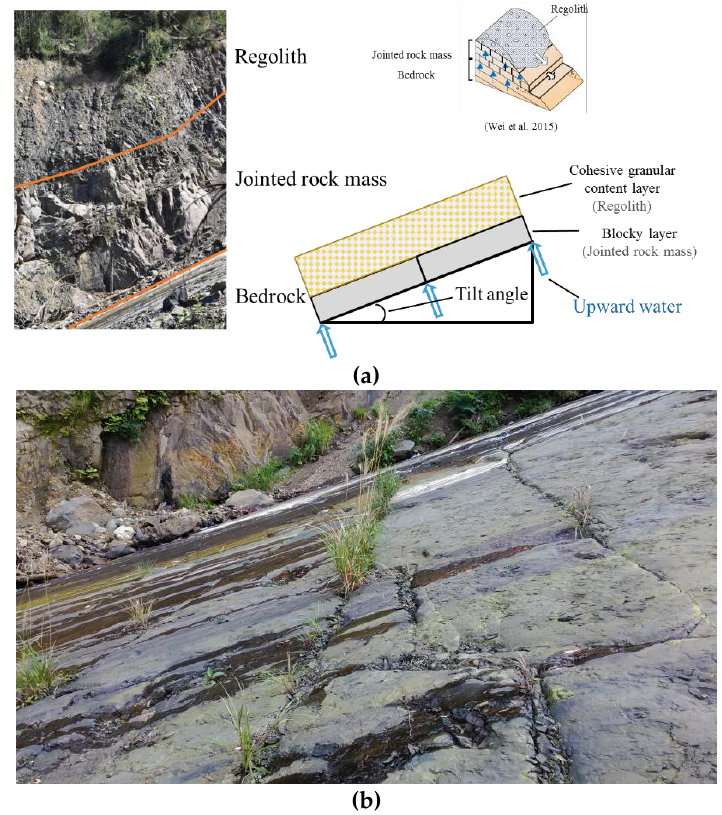
Figure 3. Profile and conceptual model of cataclinal slope ( a ) and groundwater emerging out of slope surface along joints ( b ).